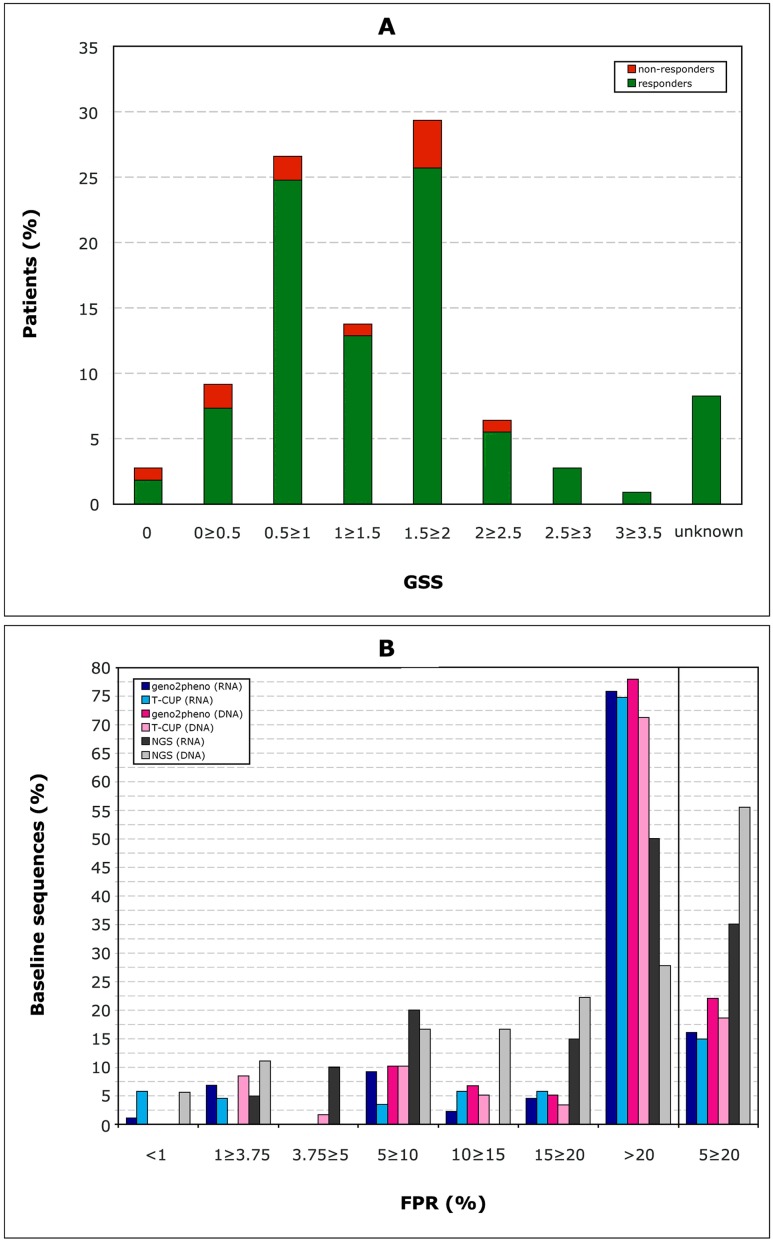
Baseline characteristics.Panel A: Number of active drugs in the GSS. Panel B: Distribution of the FPR of the baseline viruses: 87 RNA and 60 DNA sequences with single population-based sequencing, and 20 RNA and 18 DNA samples analysed by NGS.